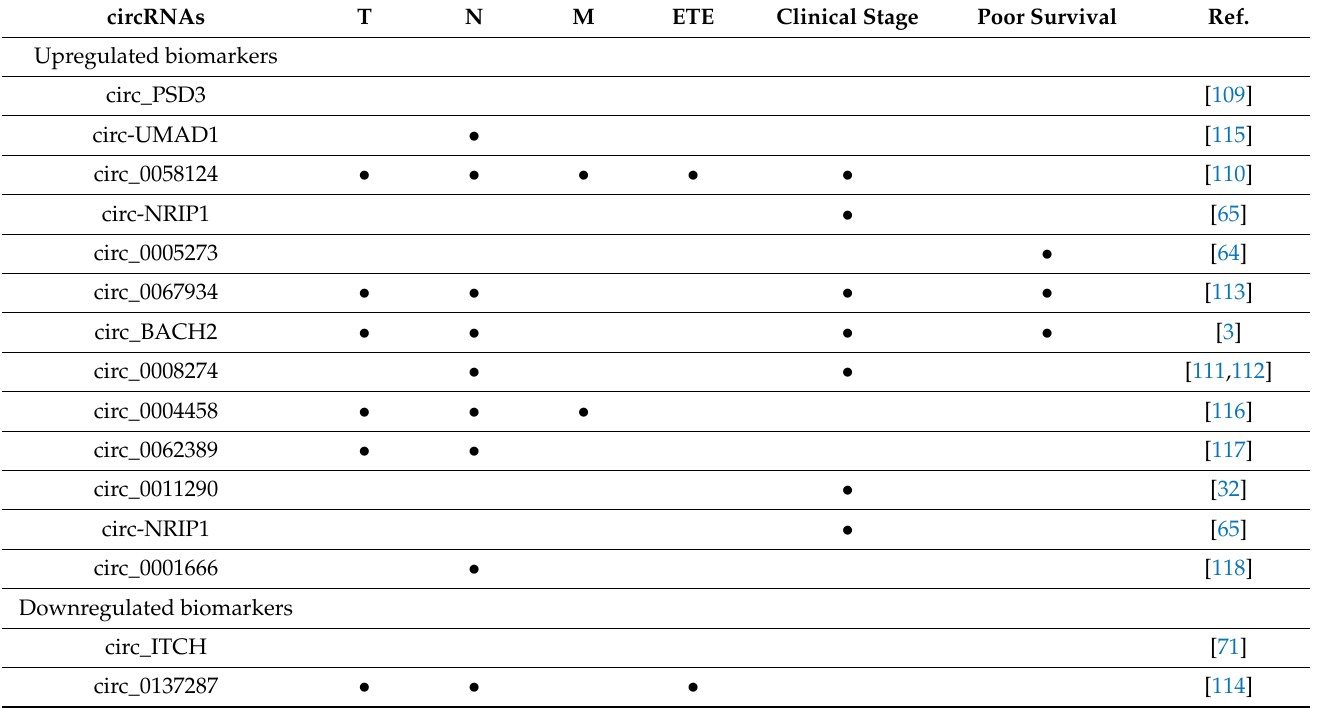
Table 2. Role of circRNAs as diagnostic and prognostic biomarkers in PTC patients. Clinical Stage circRNAs